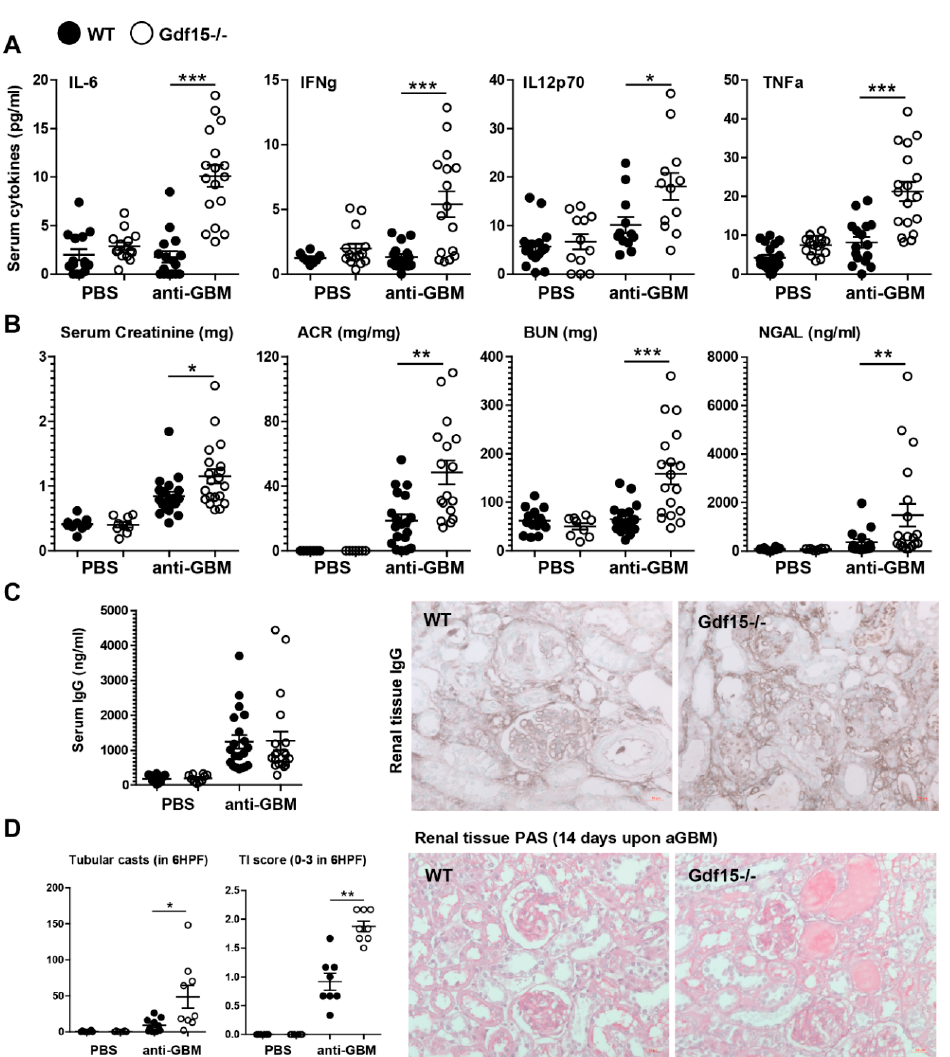
Figure 2. Systemic inflammation, kidney function, and histopathology of anti-GBM nephritis. ( A ) Sera were obtained from wild type or GDF15-deficient C57BL / 6 mice on day 14 after saline or antiserum (anti-GBM) injection. Cytokine levels were quantified by flow cytometry ( n = 15–17, one-way